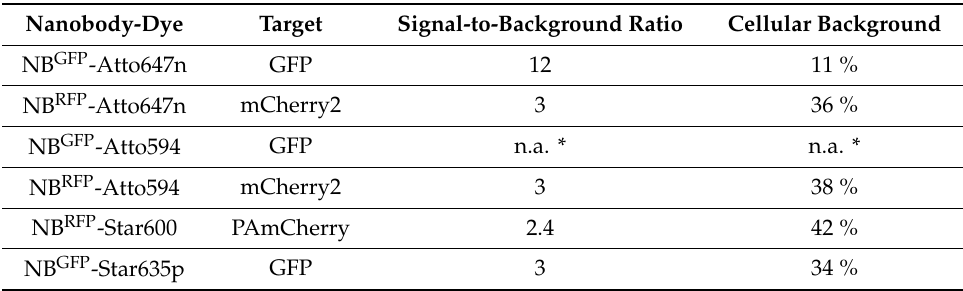
Figure 3. Comparison of Atto647n and Star635p for bacterial STED imaging. B. subtilis cells expressing either DivIVA-GFP or DivIVA-mCherry2 were visualized using nanobodies conjugated with Atto647n or Star635p. STED images show an enlarged field of view of the object marked with an arrow in the confocal image. Scale bars 1 μ m and 0.5 μ m, for confocal and STED images, respectively. Table 1. Summary of Dyes Performance for STED Imaging in Bacterial